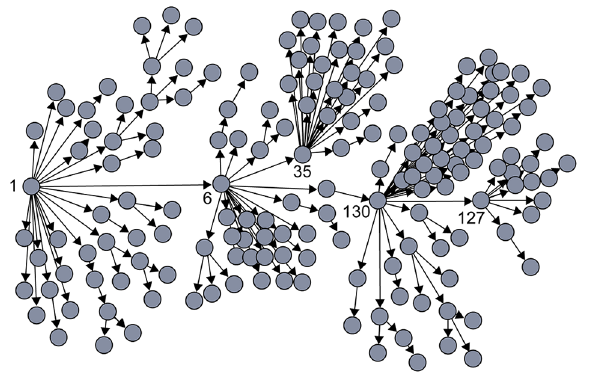
Figure 1. Contact tracing of SARS in Singapore showed that most people (gray circles) transmitted the virus to very few others, while a few individuals acted as ‘‘super- spreaders,’’ infecting many more people than average. Patient numbers corresponding to those individuals who were identified as superspreaders are shown. All cases trace back to patient 1 [18]. cell-to-cell transfer of HIV infection in the genital mucosa.